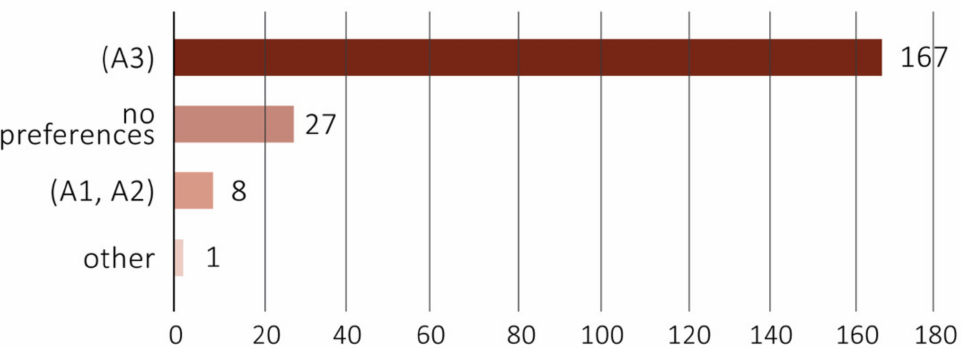
Figure 3. Frequencies concerning the users’ preferences among the different kinds of hand sanitizing systems (A1, A2, A3). Own